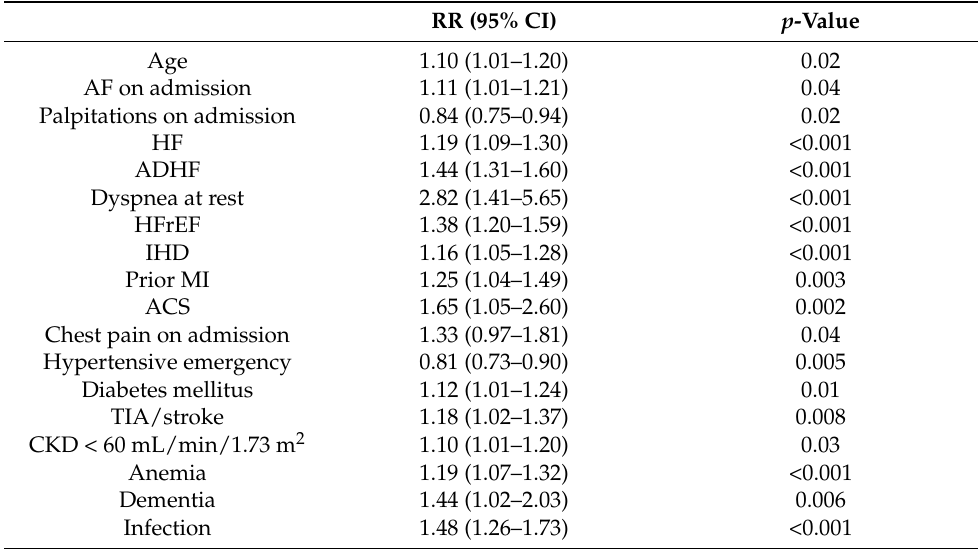
Table 2. Determinants of prolonged LOS—univariate analysis.